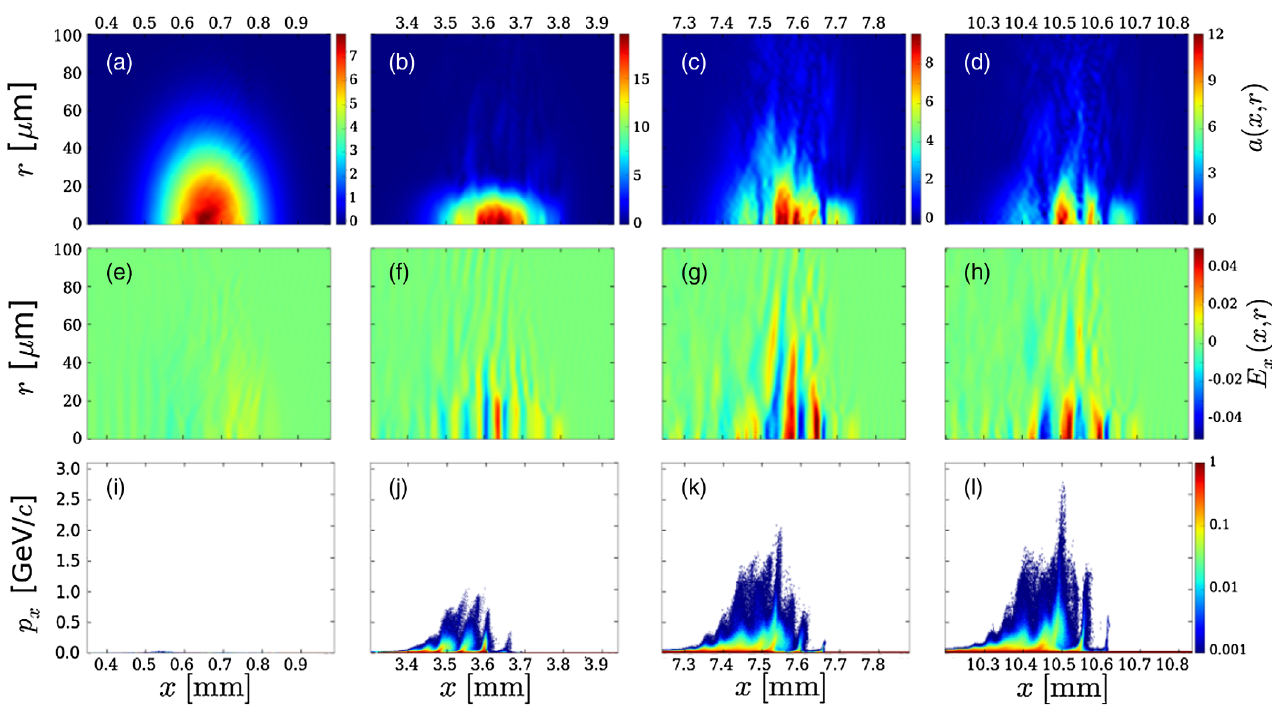
1 . 1 × 10 18 cm − 3 . The columns (from left to right) FIG. 1. Hot electron generation in the SM-LWFA at the plasma density n e ¼ correspond to the propagation distances 0.9, 3.9, 7.9, and 10.8 mm (the Rayleigh length being 5.5 mm). Snapshots of the laser envelope ≈ 30 μ m. Images (e – h) of (a – d) reveal longitudinal breakup of the pulse into beamlets with the size close to the plasma wavelength, λ p c ω 0 =e ) reveal excitation of a broken plasma wake, which traps and accelerates electrons to the longitudinal accelerating field (in units m e GeV energies, as evidenced by the snapshots of longitudinal phase space (i – l).